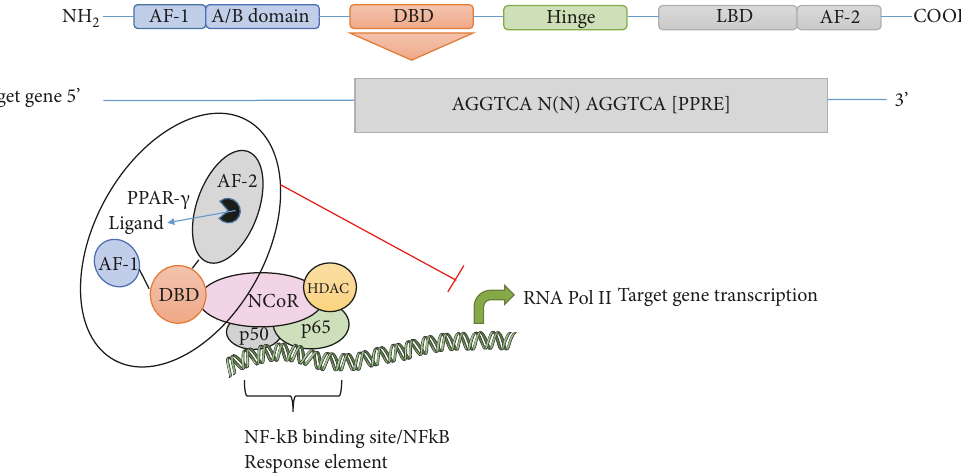
Figure 2: PPAR 𝛾 mediated transrepression of NF- 𝜅 B through SUMOylation modification. Binding of PPAR 𝛾 ligand to the AF-2 domain at Lys-365 position is important in regulation of inflammatory gene expression through transrepression. Additionally, recruitment of NCoR with inhibition of NCoR proteosomal degradation